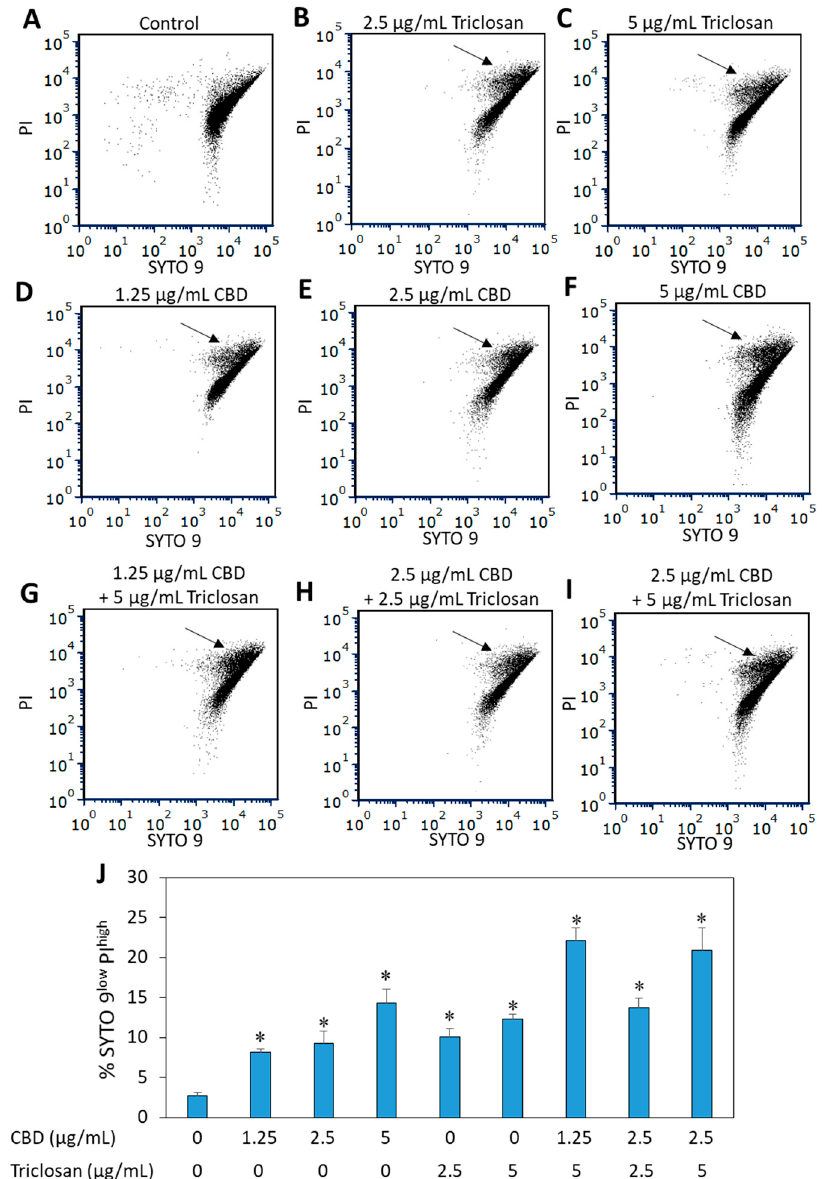
Figure 3. Increased membrane permeability following treatment with CBD and/or triclosan. ( A – I ) PI versus SYTO 9 dot plot analysis of S. mutans that was exposed to the indicated concentrations of triclosan and CBD for 1 h. The black arrows point to the SYTO 9 low PI high bacterial population, which represents bacteria with disrupted membrane. ( J ) The percentage of the SYTO 9 low PI high bacterial population. * p < 0.05 compared to control bacteria. N = 3.